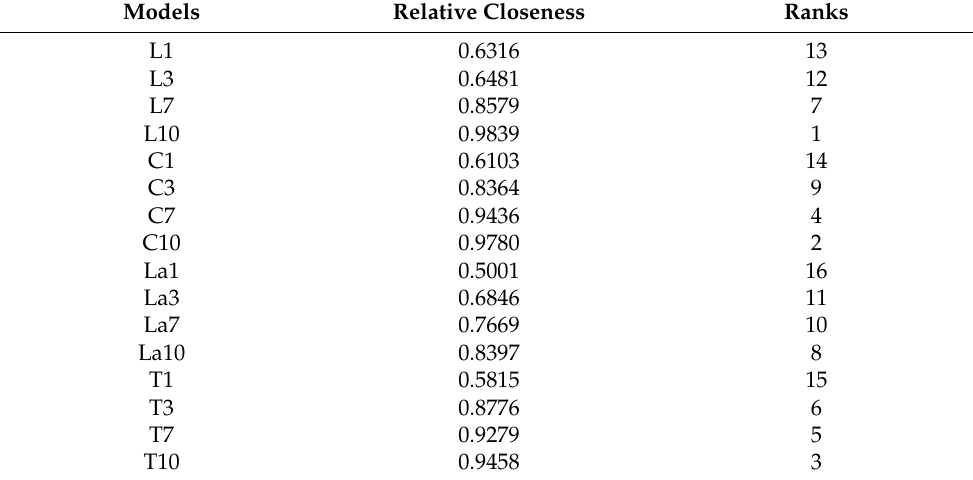
Table 16. Ranking models for Bitfinex dataset.